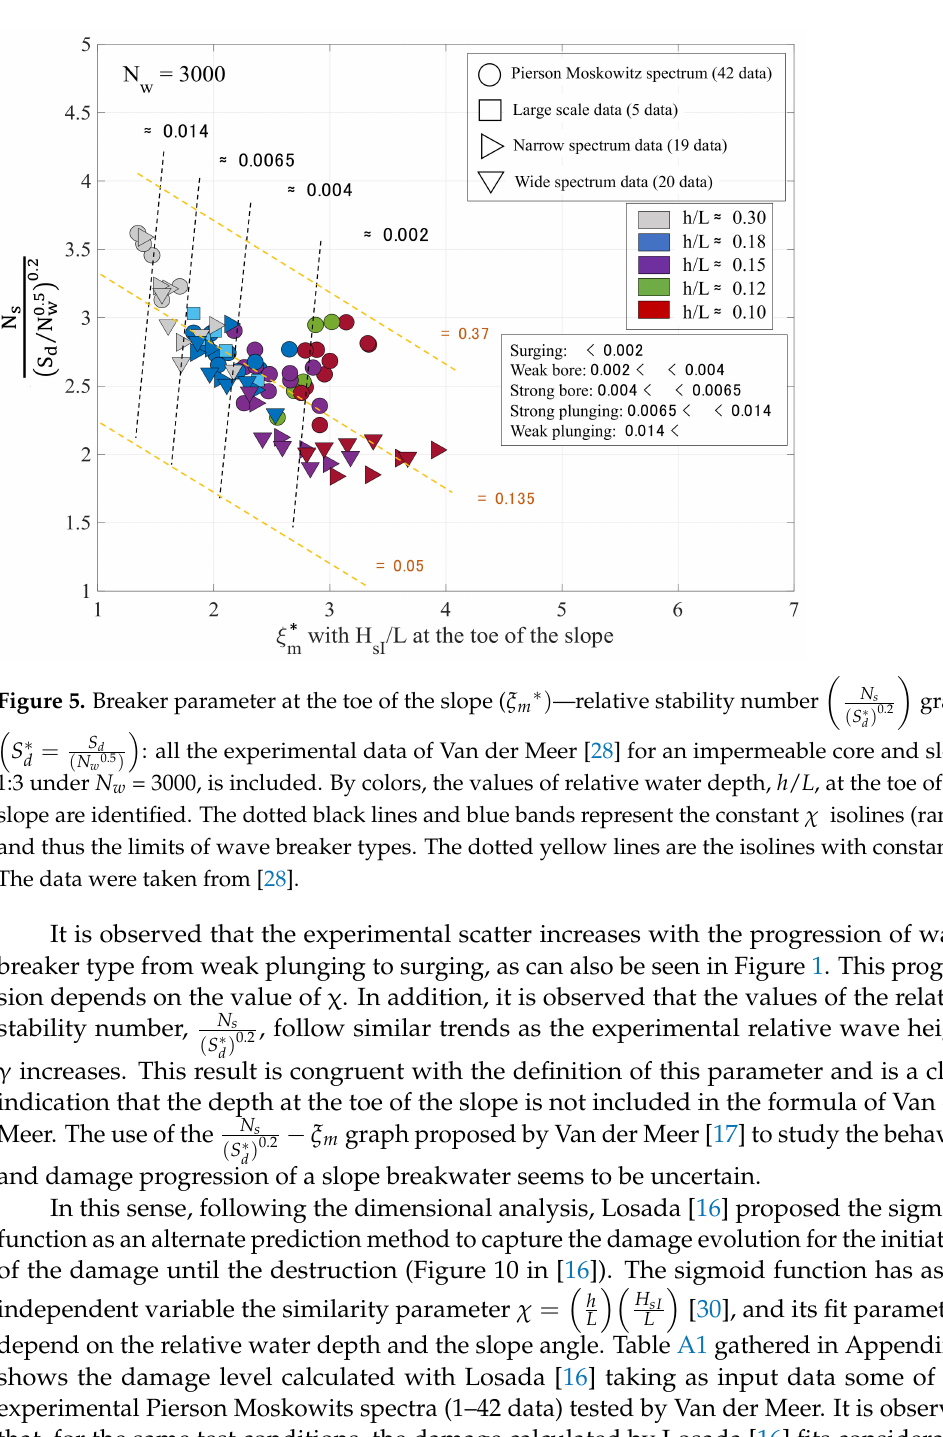
Figure 5. Breaker parameter at the toe of the slope ( ξ m ∗ ) —relative stability number (cid:16) (cid:17) = S d S ∗ : all the experimental data of Van der Meer [28] for an impermeable core and slope ( N w 0.5 ) d 1:3 under N w = 3000, is included. By colors, the values of relative water depth, h / L , at the toe of the slope are identified. The dotted black lines and blue bands represent the constant χ isolines (range) and thus the limits of wave breaker types. The dotted yellow lines are the isolines with constant γ . The data were taken from